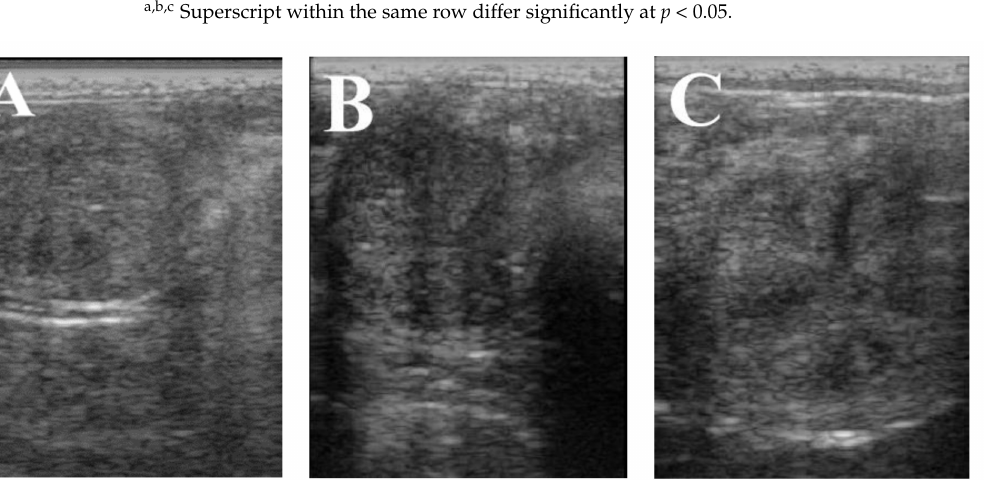
Figure 2. Ultrasonography image for uterine horn thickness on day 5 of the estrus phase in the control ( A ), platelets-rich- plasma (PRP) ( B ), and L-GF equina ( C ) treated groups of pure Arabian mares who experienced repeat breeding.